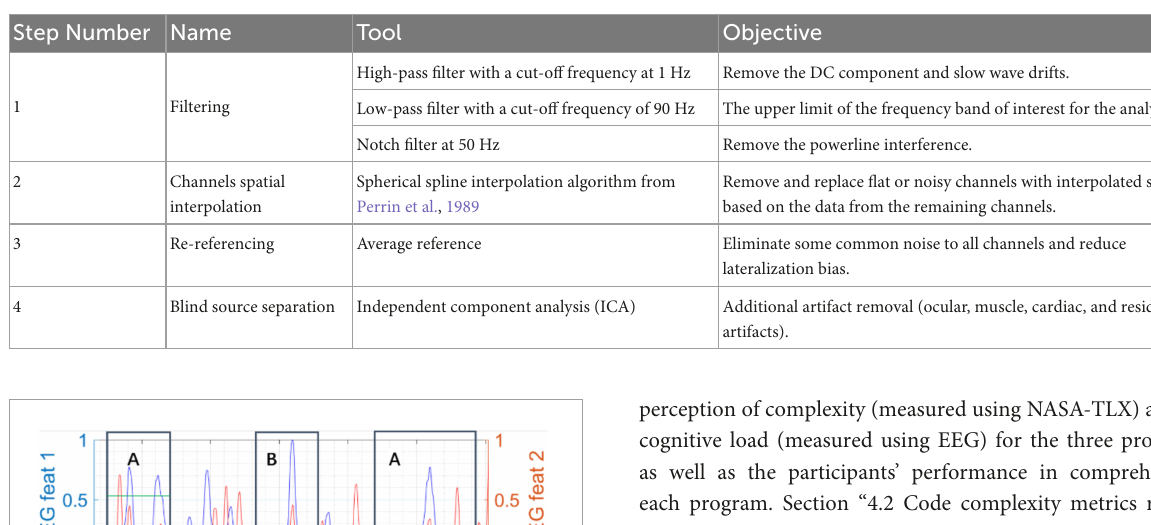
TABLE 4 The procedure of EEG signal processing.